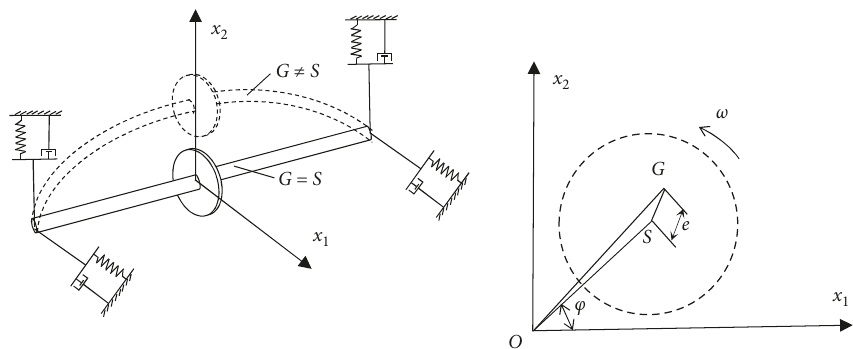
Figure 1: Diagram of the motorized spindle